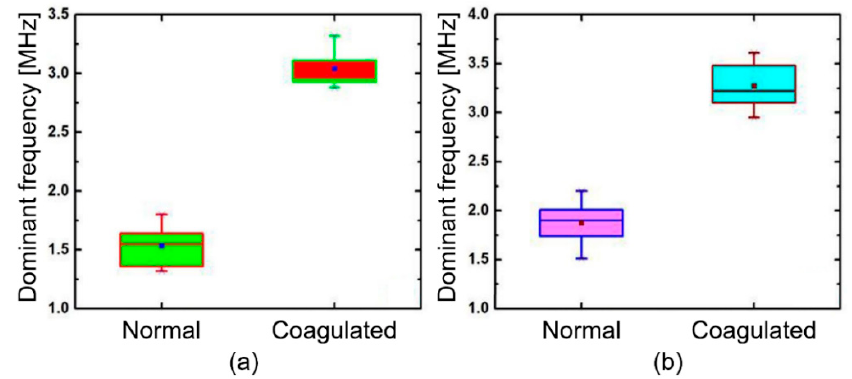
Figure 5. Comparison of dominant frequencies obtained from four muscle and liver tissues: ( a ) muscle and ( b ) liver. The shaded box represents a 25–75% range of each data set. The line and the dot within each box show the median and the mean value, respectively.